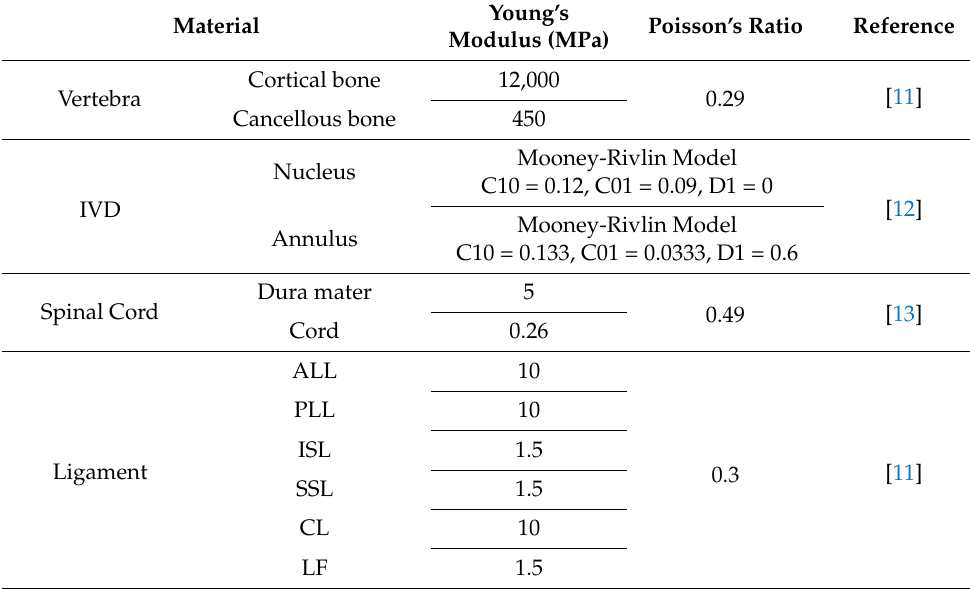
Table 1. Material properties of the cervical spine model.